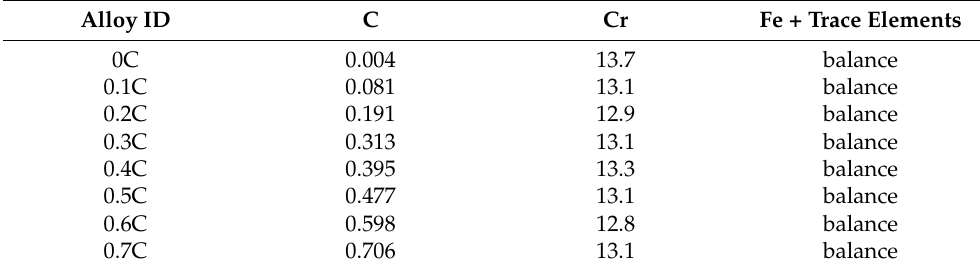
Table 1. Chemical composition of alloys in